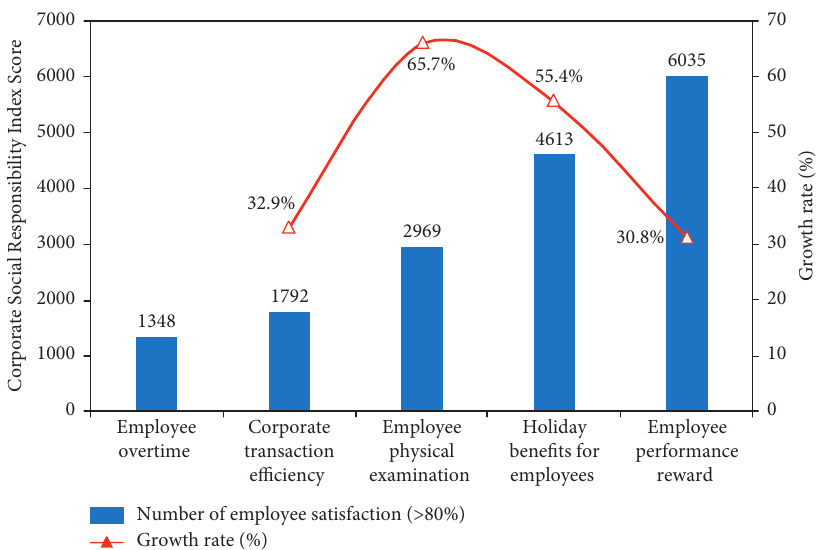
Figure 6: Analytical results of human resources related data and corporate social responsibility index.